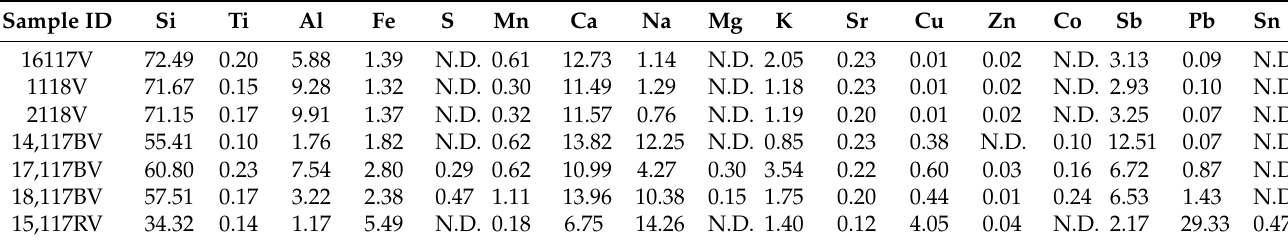
Table 2. EDXRF elemental data (wt.%) of glass tesserae